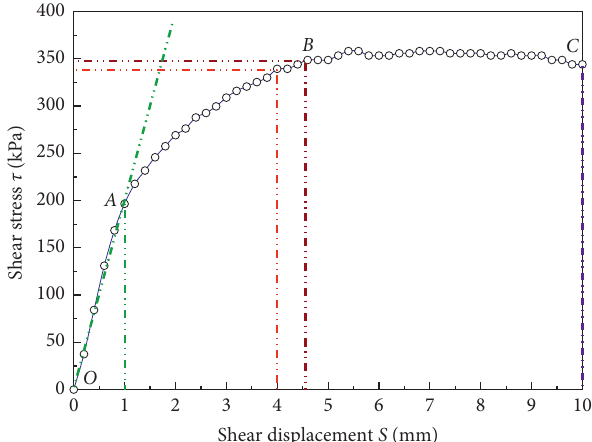
Figure 3: Shear stress-displacement curve from the half-mold direct shear